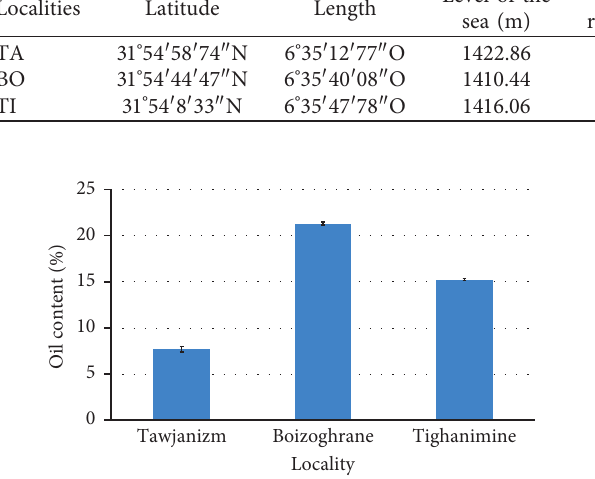
Figure 1: Oil content of lentisk seeds from the three